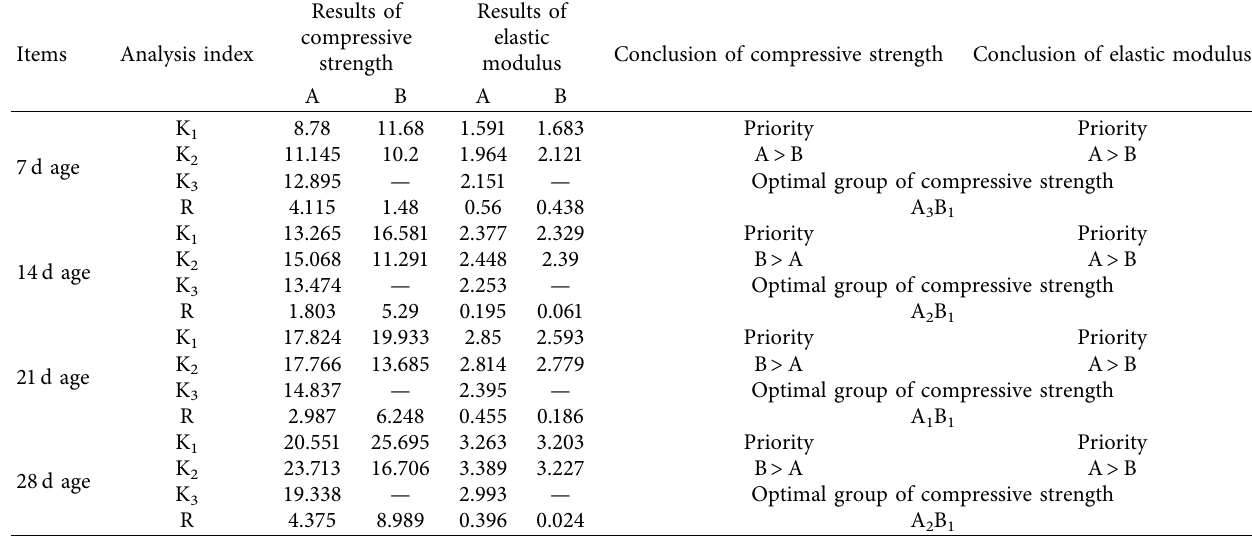
Table 5: Differentials of orthogonal tests.